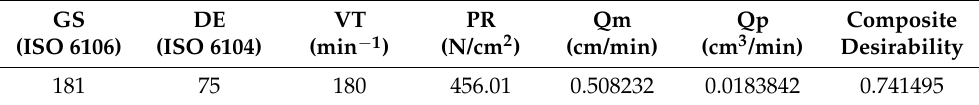
Table 3. Multi-objective optimization considering the same level of importance for Qm and